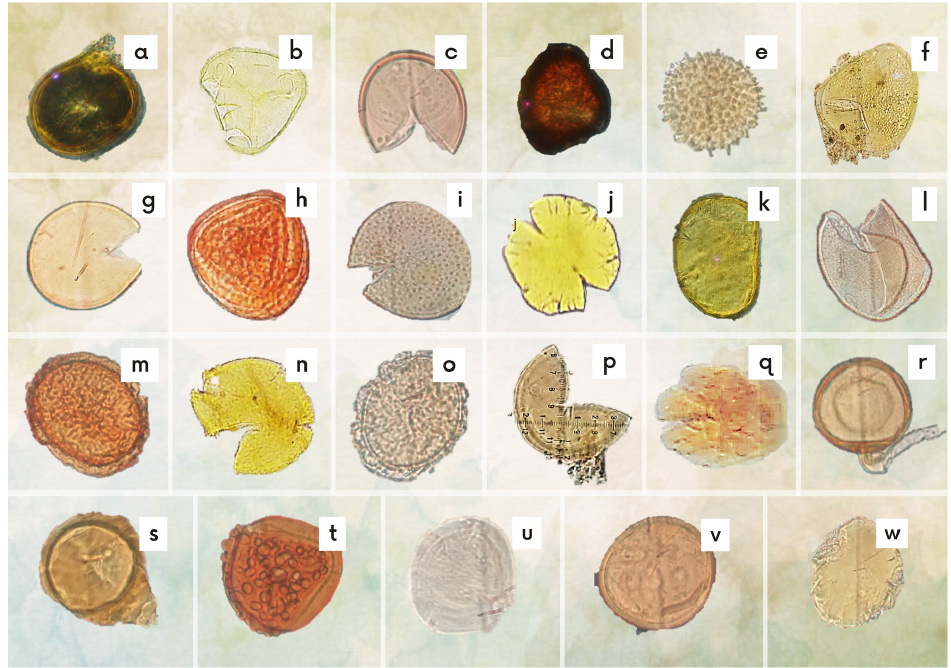
Figure 3. Genera of arbuscular mycorrhizal fungi in cocoa crops under conservative cultivation practices, identified according to spore morphological analysis: ( a – c ) Glomus , ( d , e ) Scutellospora ,